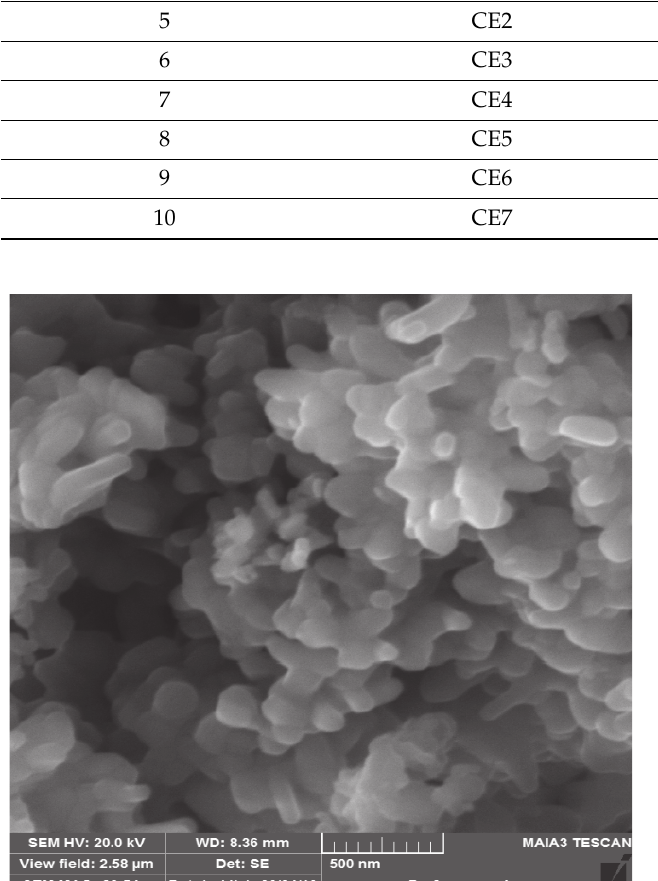
Figure 3. XRD spectrum of CuO NPs, ET, MT, and synthesized nanomaterials.